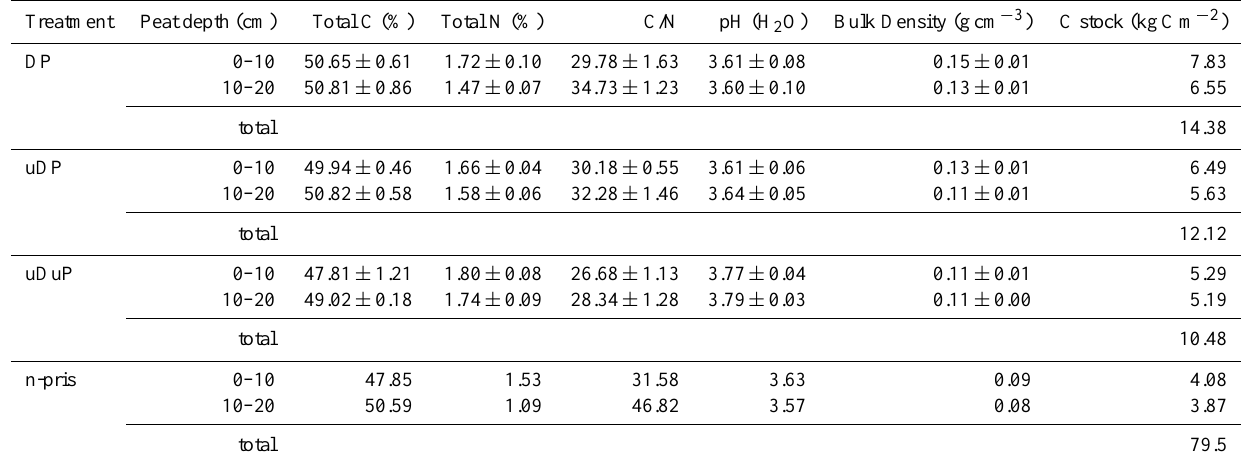
Table 2. Major top peat layer characteristics of the study site at Flanders Moss.